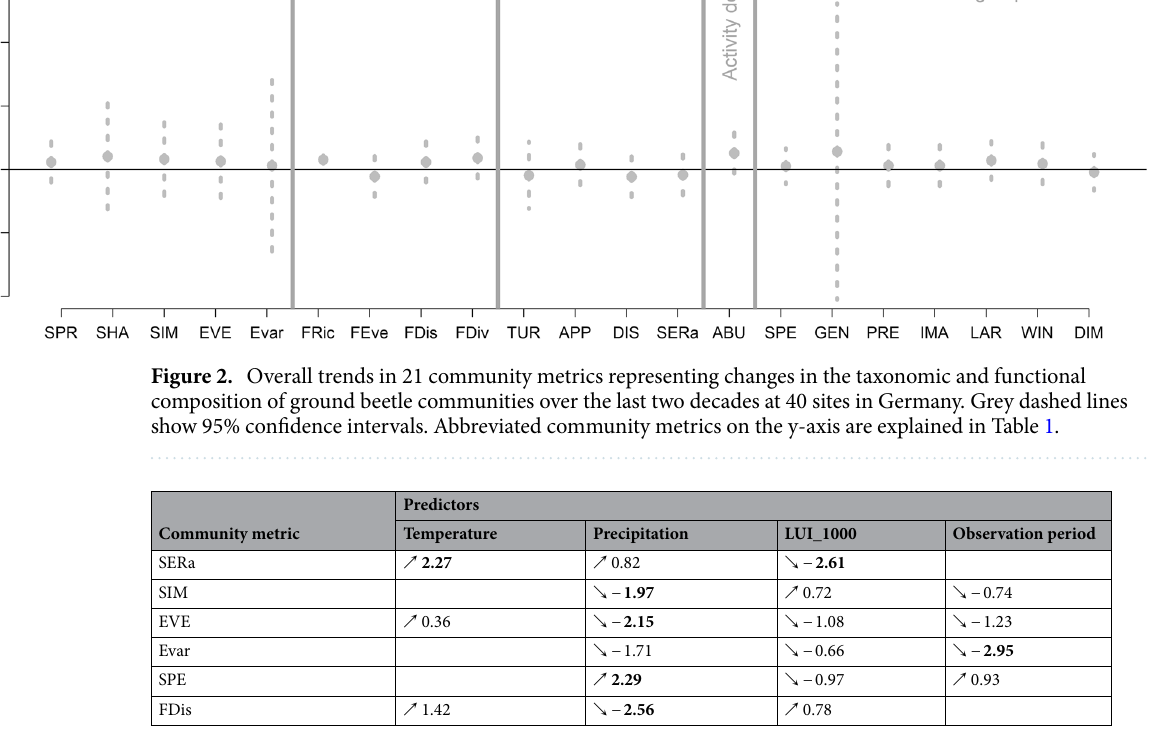
Table 2. Drivers with a significant influence on the overall trends in community metrics. Arrows indicate the direction of effect sizes (z values) of influential drivers identified in the model selection and multi-model inference procedures. Bold font indicates significant drivers and their effect sizes. Abbreviations of community metrics are explained in Table